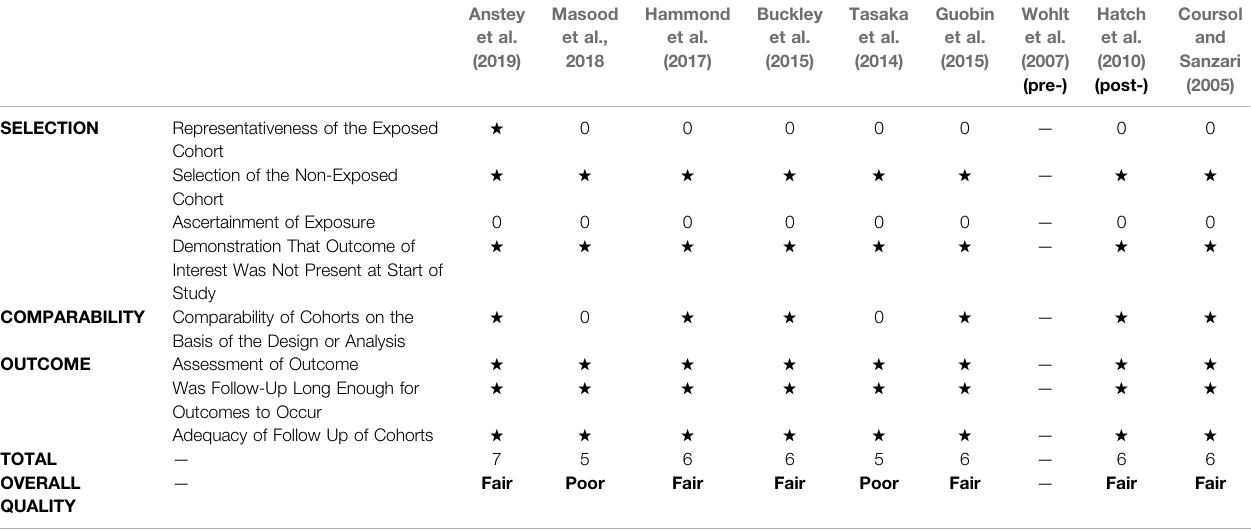
TABLE 3 | Risk of bias of included